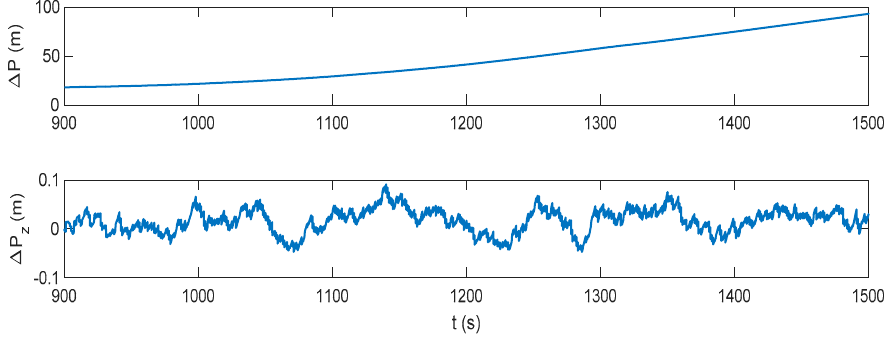
Figure 18. Position error of the IMM-aided ZUPT solution during the DVL outage.